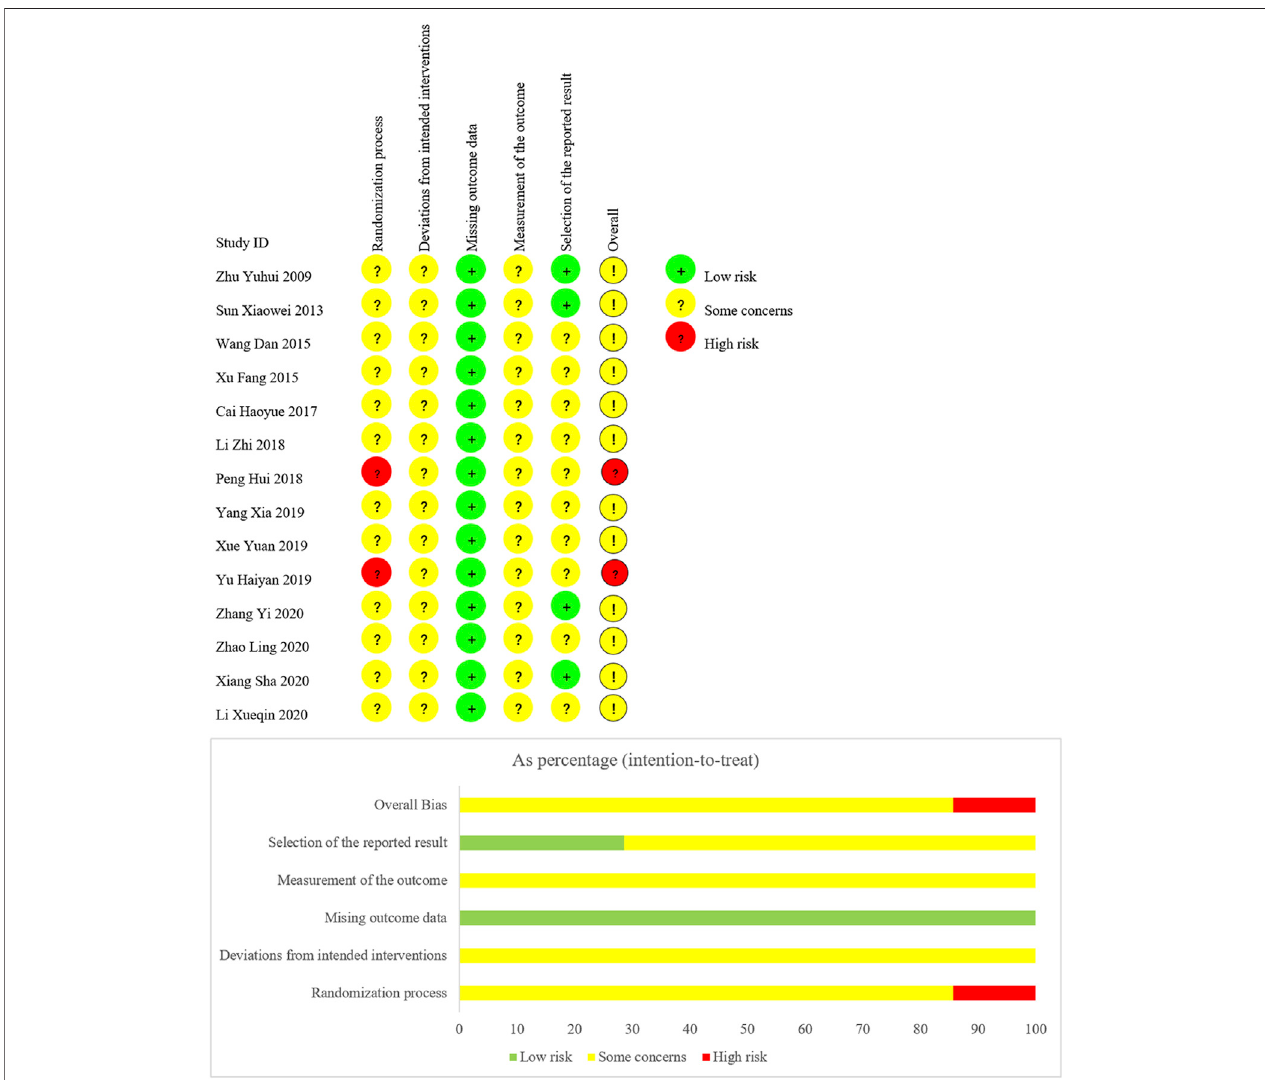
FIGURE 3 | Risk of bias of included